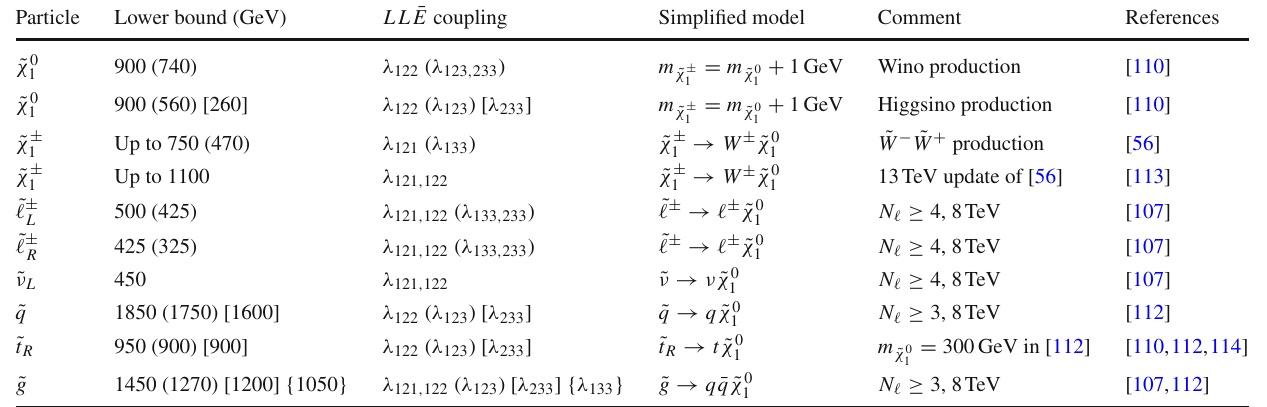
Table 4 Best limits in RPV searches using simplified models and LL ¯ E operators. The pair-produced SUSY particles are assumed to decay down to the neutralino LSP which itself always decays as ¯ E ˜ χ 0 → (cid:8) ± (cid:8) ∓ ν , (cid:8) ± (cid:8) ∓ ν , for L j i i L j k . The bounds are only estimates, i k j k 1